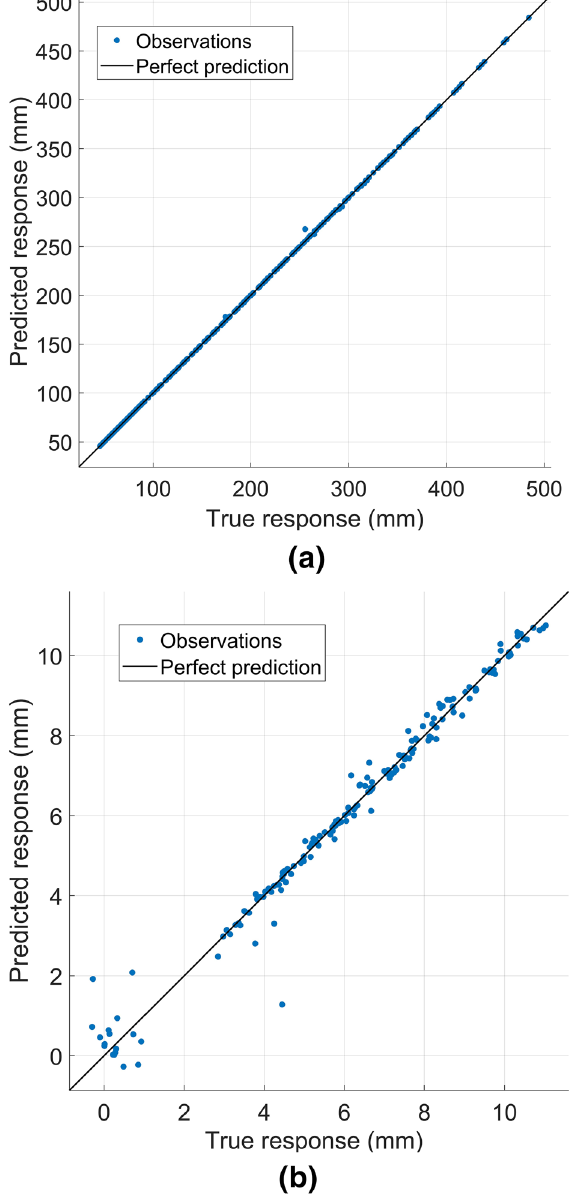
Figure 8. Predicted and true responses of effective working lengths and variation of effective working length of each spiral arm. ( a ) Effective working lengths of each spiral arm ( L e ); ( b ) Variation of effective working length of each spiral arm ( (cid:31) L